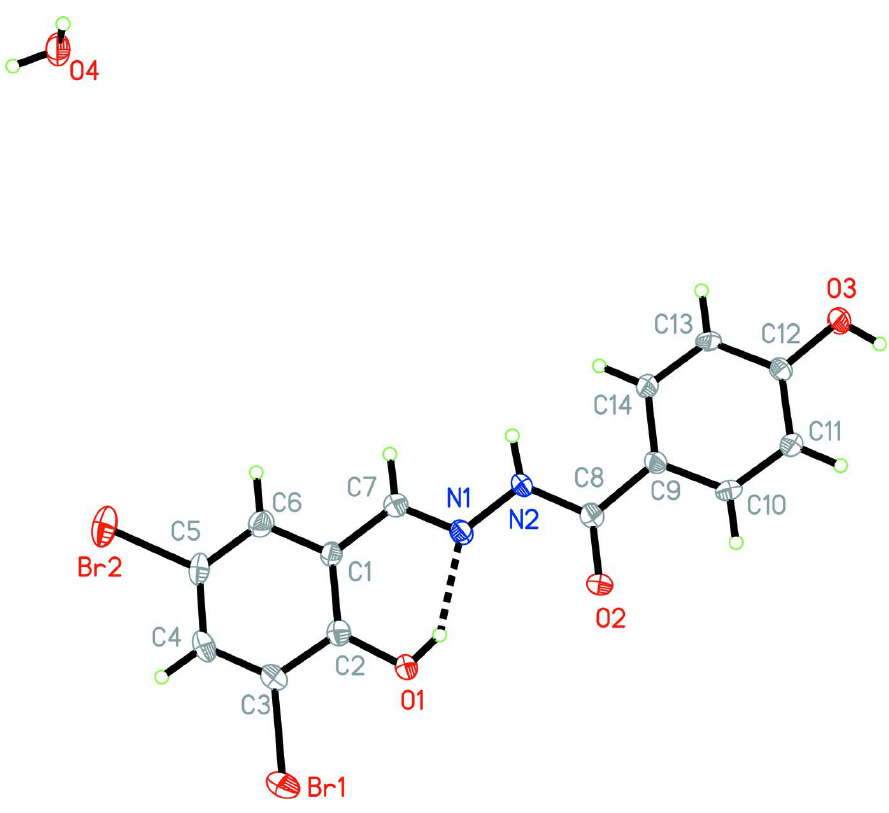
Figure 1 The molecular structure of (I) with ellipsoids drawn at the 30% probability level. Water and main molecule are placed in two different asymmetric units.